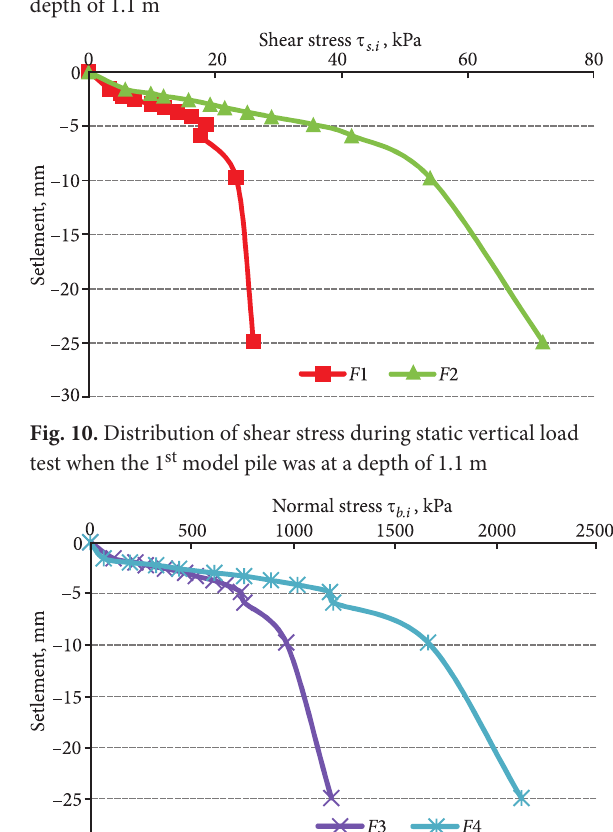
fig. 13. Distribution of shear stress during static vertical load test when the 1 st model pile was at a depth of 1.4 m